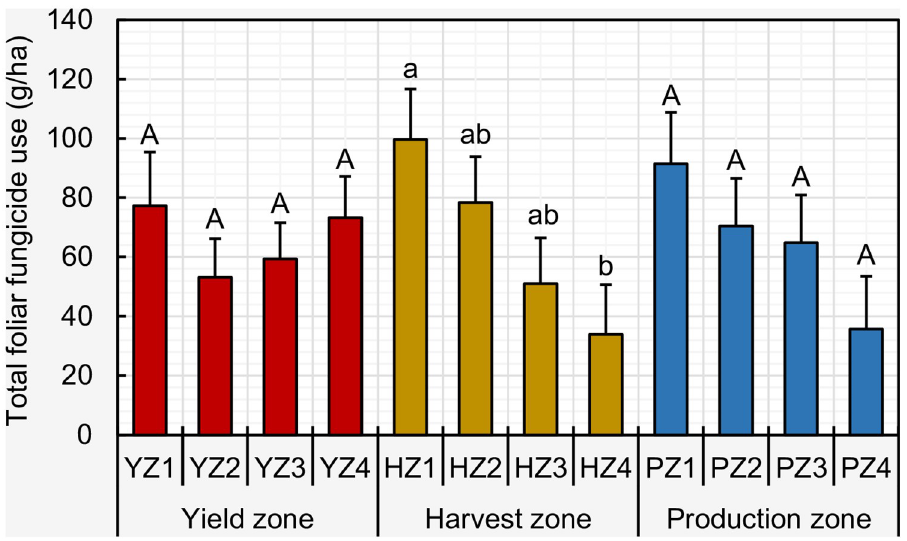
Fig 5. Comparison of the mean per hectare foliar fungicide use (in g) among yield/harvest/production zones. Within each zone type, means followed by a common letter are not significantly different after adjustment for multiple comparisons using Tukey-Kramer test at the 5% level of significance. Error bars represent standard errors. Foliar fungicides included: quinone outside inhibitors = azoxystrobin, fluoxastrobin, picoxystrobin, pyraclostrobin, trifloxystrobin; demethylation inhibitors = cyproconazole, difenoconazole, flutriafol, propiconazole, prothioconazole, tebuconazole, tetraconazole; methyl benzimidazole carbamates = thiophanate-methyl; multi-site mode of action = chlorothalonil; and succinate dehydrogenase inhibitors = fluxapyroxad (effective against anthracnose, Cercospora leaf blight (purple seed stain), frogeye leaf spot, Rhizoctonia aerial blight, Sclerotinia stem rot (White mold), Septoria brown spot, and soybean